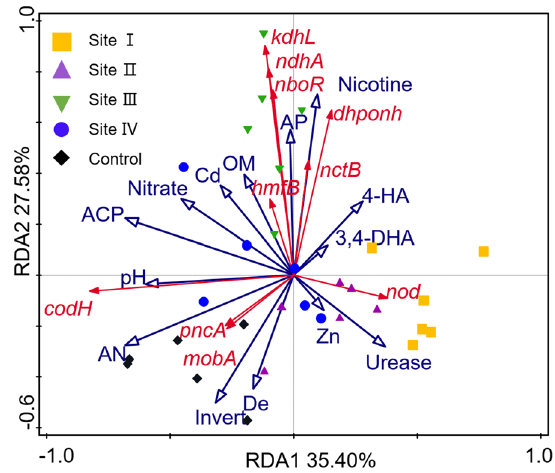
Fig. 7 Redundancy analysis of the relationships among nicotine concentrations, abundance of nicotine-degrading genes and some soil properties in tobacco rhizosphere soils. codH aerobic carbon-monoxide dehydrogenase gene, ndhA nicotine dehydrogenase subunit gene, kdhL 6-hydroxypseudooxynicotine dehydrogenase subunit gene, hmfB 2-furoyl-CoA dehydrogenase gene, mobA molybdenum cofactor cytidylyltransferase gene, nboR nicotine blue oxidoreductase gene, dhponh 2,6-dihydroxypseudooxynicotine hydrolase gene, nctB (S)-6-hydroxynicotine oxidase gene, pncA nicotinamidase gene, nod nicotine oxidoreductase gene, De dehydrogenase, ACP acid phosphatase, AP organic phosphorus, AN alkali hydrolyzed nitrogen, OM organic matter, 4-HA 4-Hydroxybenzoic acid, 3,4-DHA 3,4-dihydroxyphenylacetic acid, Cd cadmium, Zn